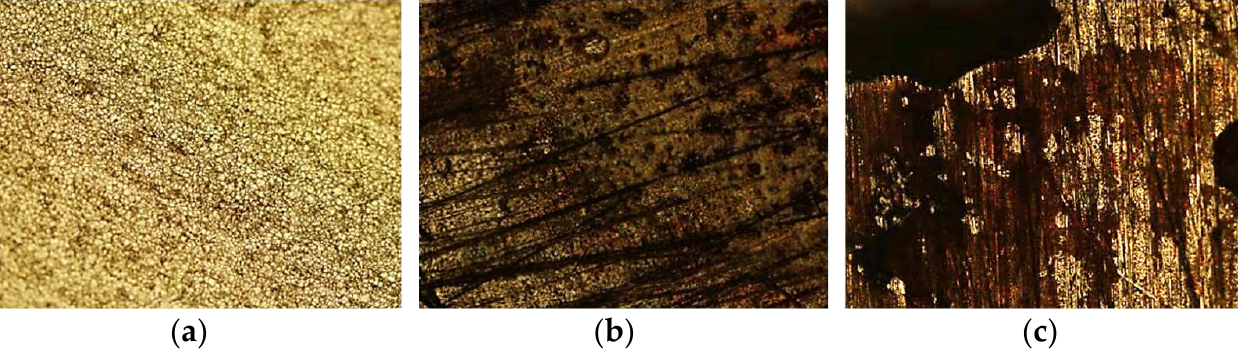
Figure 3. Optical microscope images of the AISI 316L samples at a magnification of 50×: ( a ) before immersion, ( b ) after three weeks, ( c ) after three months.